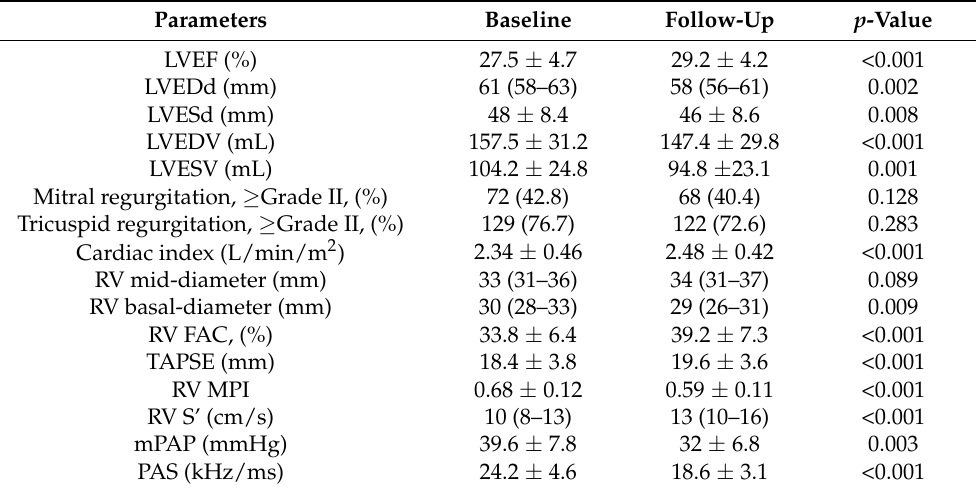
Table 2. Echocardiographic parameters before and after SGLT2 inhibitor treatment.